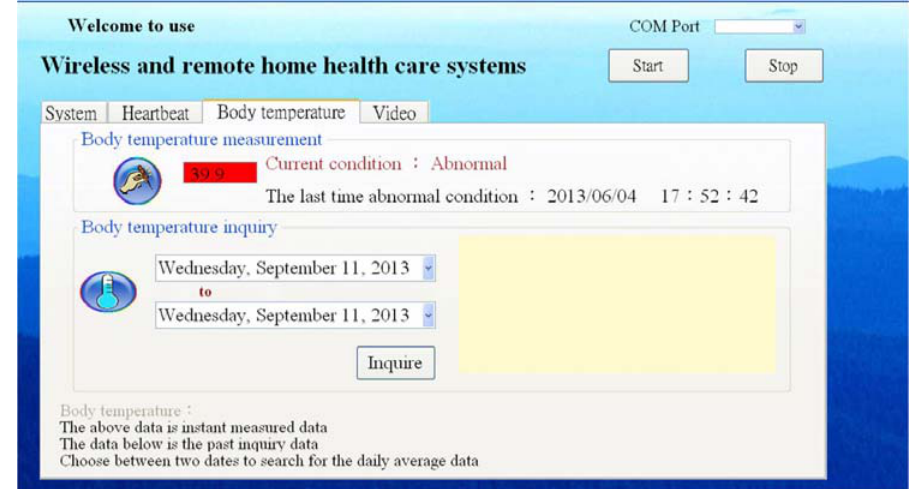
Figure 6. Exceptional human body